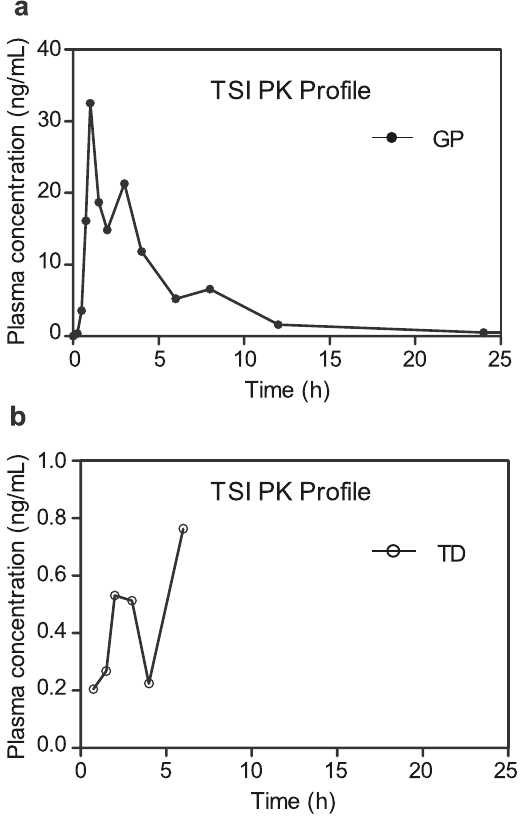
Figure 4. Plasma concentration-time profiles for tanshinone I in subject 15 after oral administration of Salvia miltiorrhiza ( a ) granule powder (GP) and ( b ) traditional decoction